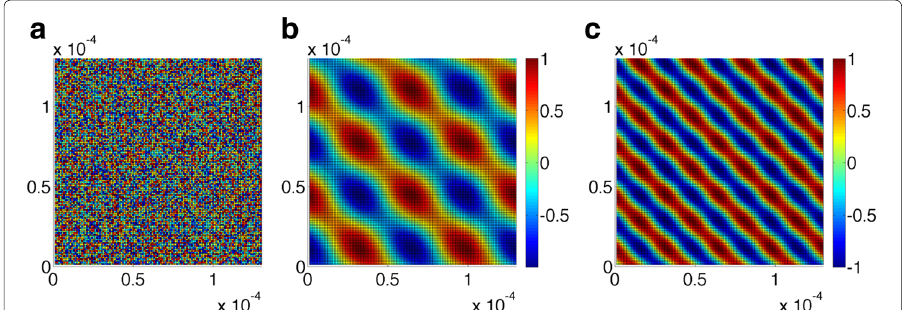
Fig. 8 Height data for the surface profiles of the ( a ) original surface prior to evolution, and surface after 60 h of evolution using ( b ) the linear evolution equation and ( c ) nonlinear evolution equation. The surface height is normalized to the maximum height, where average height of the surface is 0. The peaks are shown by the red regions while the troughs are shown as blue . The x - and y-axes are expressed in [m] to show the feature size. The evolution parameters are as shown in Table 1. θ =